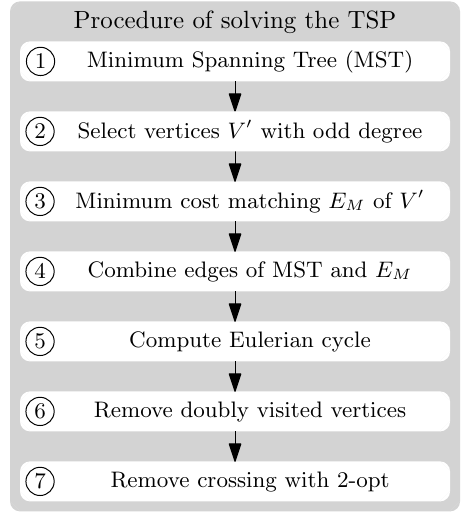
Figure 3: Summary of Christoffides’ algorithm with an ad-ditional step of removing